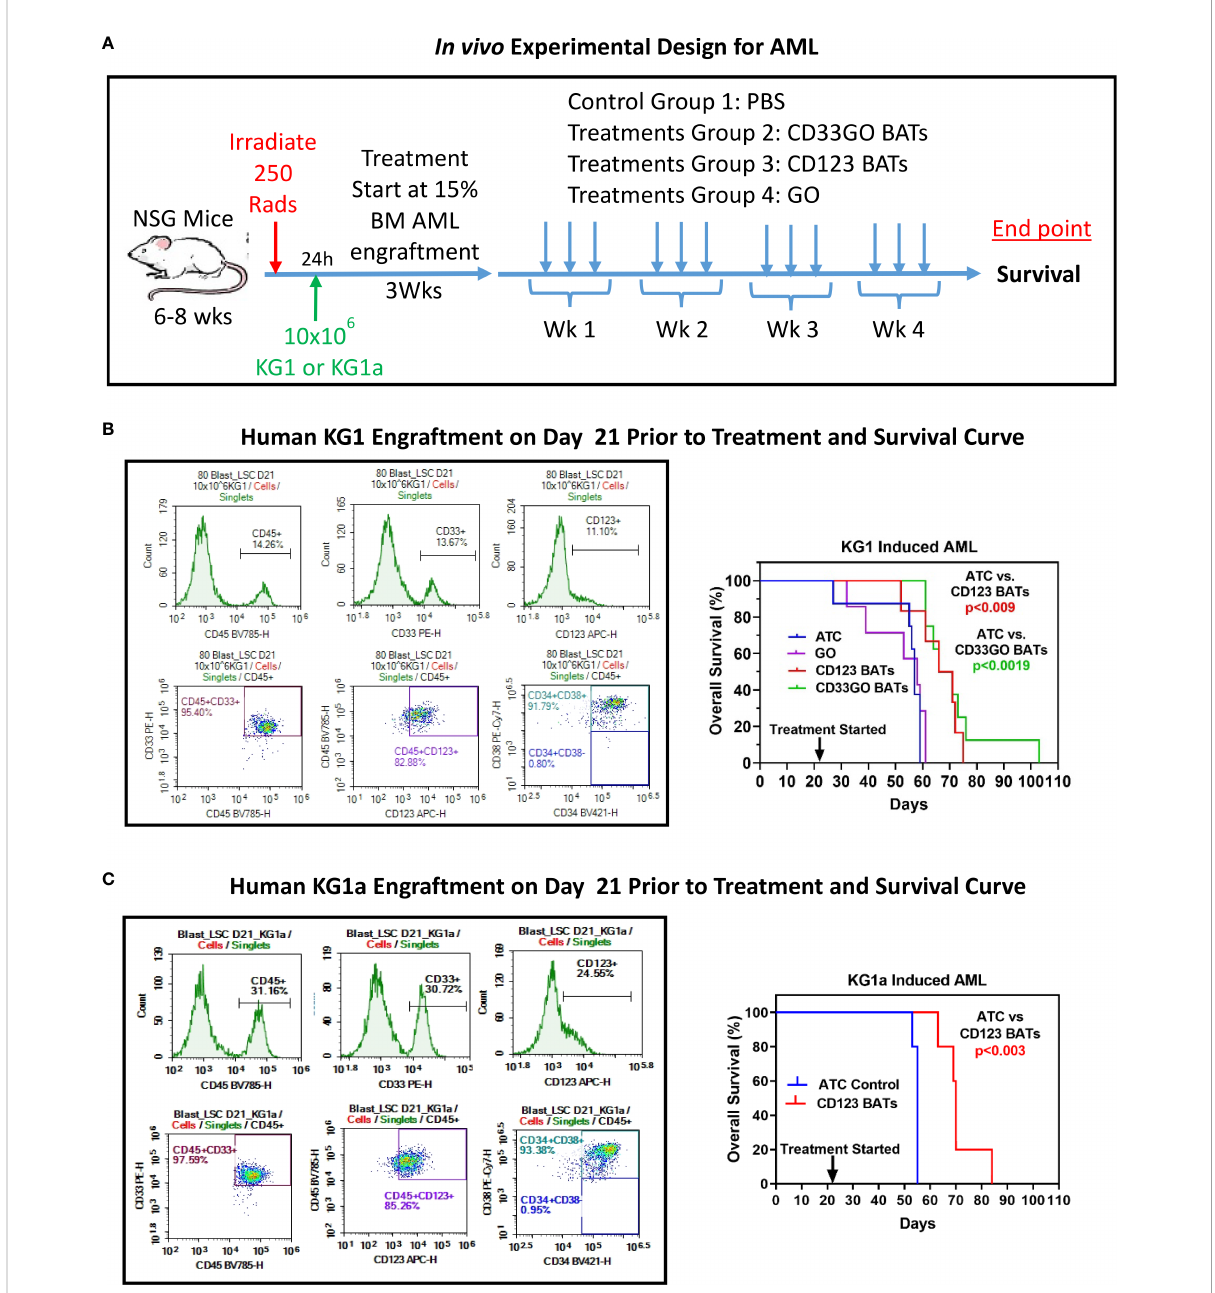
FIGURE 6 In vivo Ef fi cacy of CD33GO and CD123 BATs against AML in NSG Mice. (A) Upper panel shows treatment schema. (B) NOD scid gamma ([NSG] NOD.Cg-Prkdcscid Il2rgtm1Wjl/SzJ) mice 6-8-week-old were irradiated with 250 Rads, after 24h of irradiation mice were intravenously injected with 10x106 KG1 cells to establish human AML graft (left panel). Right panel shows the percentage of overall survival of all four groups (n=10 mice/group). Mice treated with ATC or BATs received 20x106 cells/injection, 3x/week for 4 weeks and mice treated with GO (Mylotarg) received 0.06 mg/kg GO alone 3x/week for 4 weeks. Comparison of survival curve using Log-rank (Mantel-Cox) test show signi fi cantly prolonged survival of mice treated with CD33GO BATs (p<0.0001) compared to control ATC; CD123 BATs (p<0.0089) vs control ATC; CD33GO BATs (p<0.0006) vs. GO alone and CD123 BATs (p<0.01) vs. GO alone. (C) The results of in vivo experiment were con fi rmed using AML engraftment with KG1a cells in NSG mice (n=5). Mice were treated with control ATC or CD123 BATs on day 21 when almost 30% of CD45+ KG1a cells were engrafted in the bone marrow (left panel). Mice treated with ATC or BATs received 20x106 cells/injection, 3x/week for 4 weeks. Comparison of survival curve using Log-rank (Mantel-Cox) test show signi fi cantly prolonged survival of mice treated with CD123 BATs (p<0.003) compared to control ATC (right